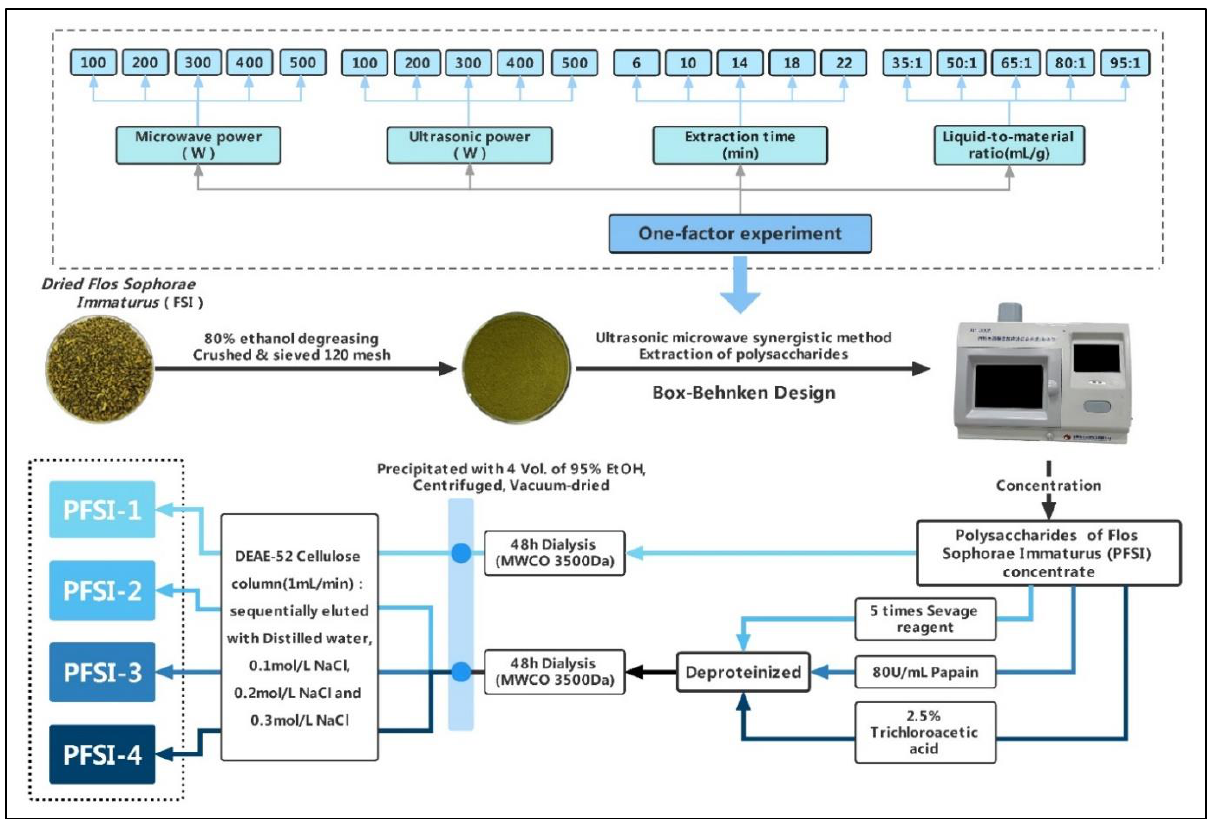
Figure 1. The procedure for extracting and purifying PFSI-1, PFSI-2, PFSI-3, and PFSI-4.